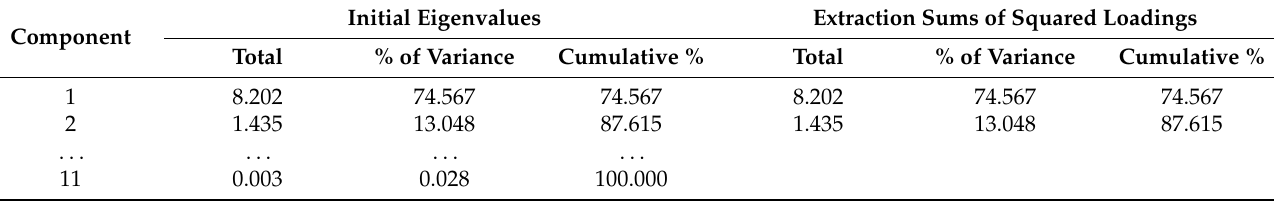
Table 4. Total variance and eigenvalues